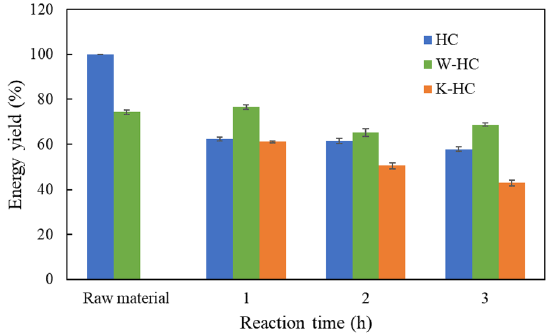
Fig. 6 Energy yield of raw material, washed sorghum, and hydrochar at 250 °C